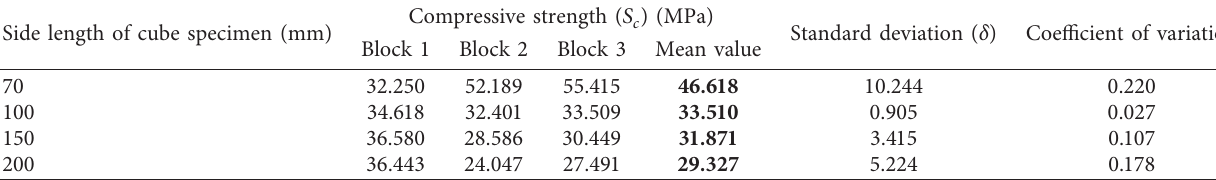
Figure 4: Experiment equipment for compressive and splitting tensile strengths. Table 5: Mean values and standard deviations of compressive